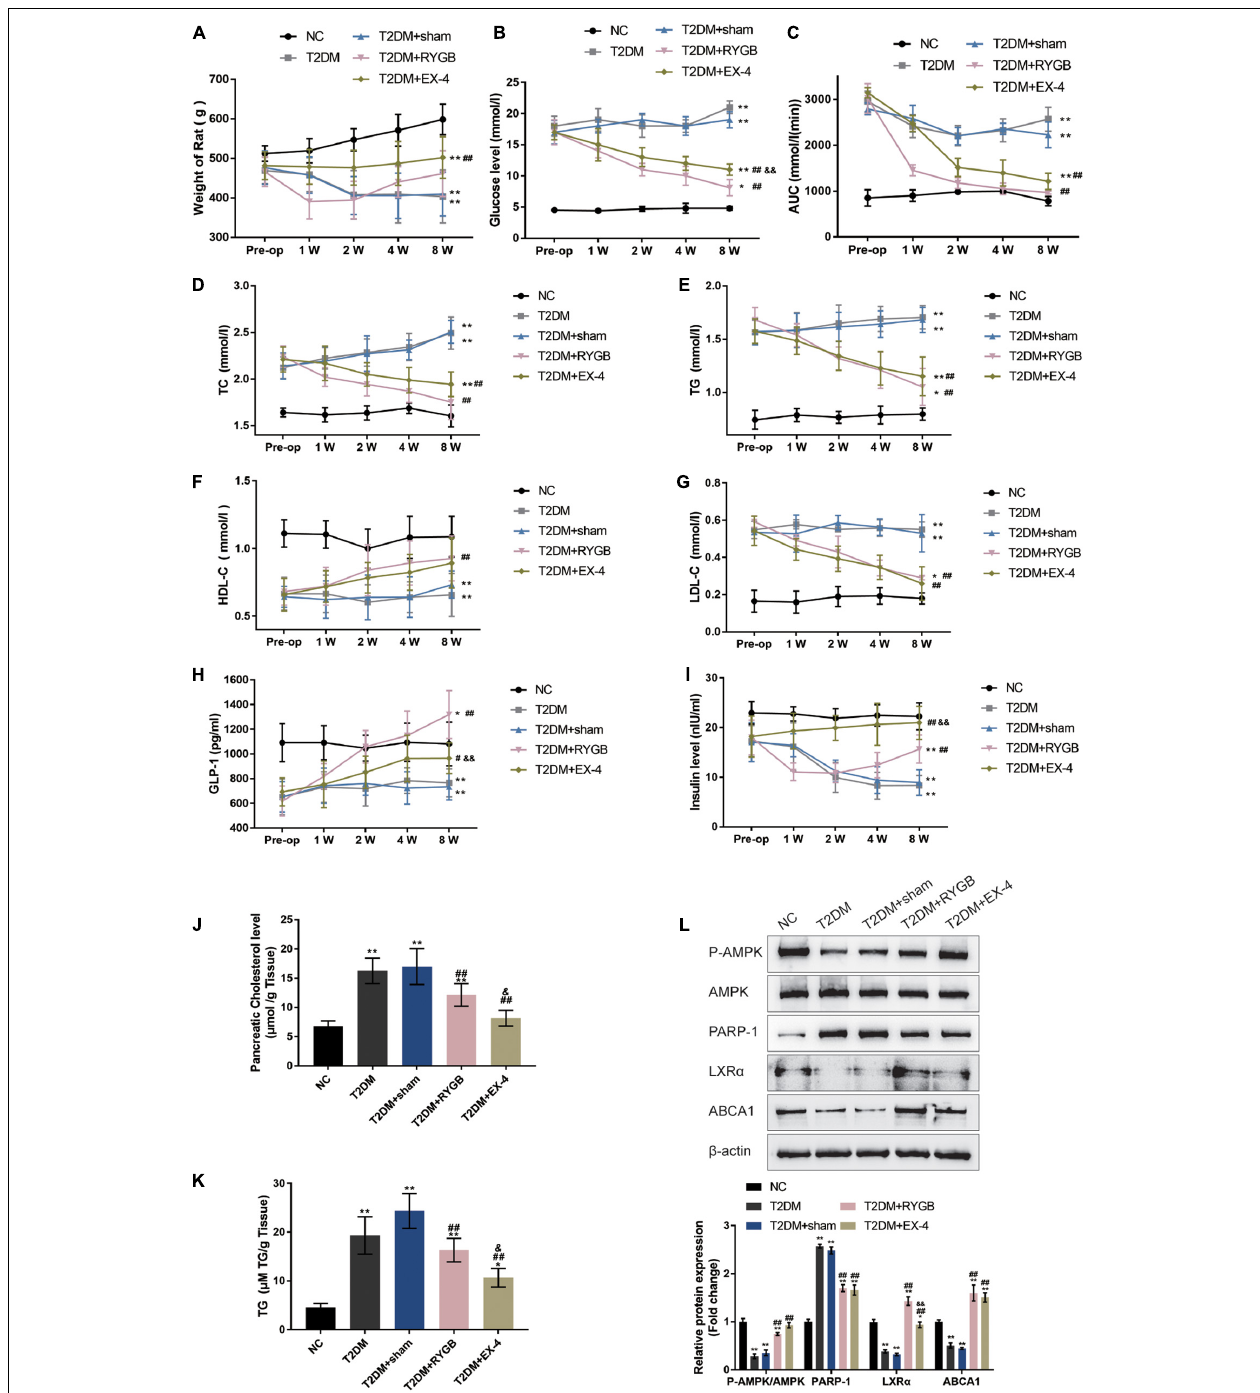
FIGURE 6 | GLP-1 inhibits PARP-1 to improve islet function in T2DM rats. Sprague-Dawley (SD) rats were randomly assigned into five groups: non-treatment control group ( n = 6), streptozotocin (STZ)-induced T2DM group ( n = 6), T2DM plus sham surgery group ( n = 7), T2DM plus RYGB surgery group ( n = 9), and T2DM plus EX-4 treatment group ( n = 8). At pre-operation (RYGB surgery or EX-4 injection), 1, 2, 4, and 8 weeks, the body weight (A) , fasting blood glucose levels (FBG) in serum (B) , the area under the curve (AUC) in serum for the OGTT (oral glucose tolerance test, mmol/L/hour) (C) , total cholesterol (TC) in serum (D) , triglyceride (TG) in serum (E) , low-density lipoprotein cholesterol (LDL-C) in serum (F) , and high-density lipoprotein cholesterol (HDL-C) in serum (G) , GLP-1 levels in serum (H) , and insulin levels in serum (I) were examined. (J,K) The TC and TG levels in pancreatic tissues of rats were determined. (L) The protein levels of p-AMPK, AMPK, PARP-1, LXR α , and ABCA1 were examined by immunoblotting in rats’ pancreatic tissues. n = 6, * P < 0.05, ** P < 0.01 compared with NC group, # P < 0.05, ## P < 0.01 compared with T2DM + sham group, & P < 0.05, && P < 0.01 compared with T2DM + RYGB group.